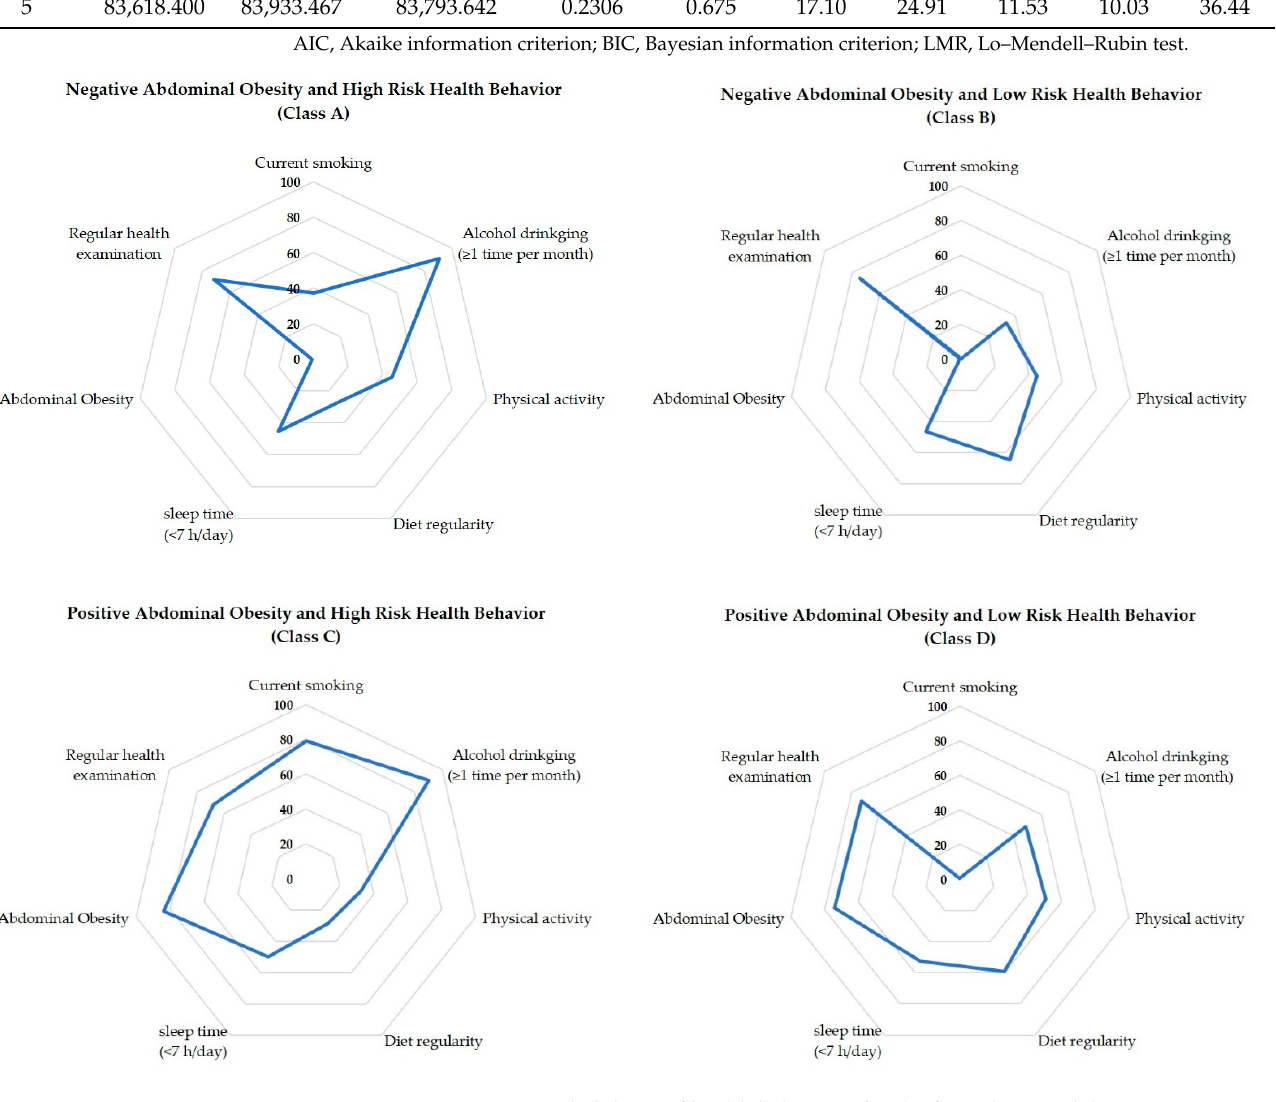
7 of 16 Table 1. Model fit statistics of the LCA models.